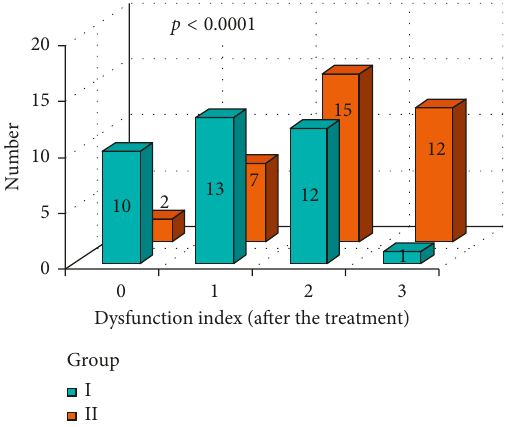
Figure 10: DI index values after the prosthetic therapy in group I and group